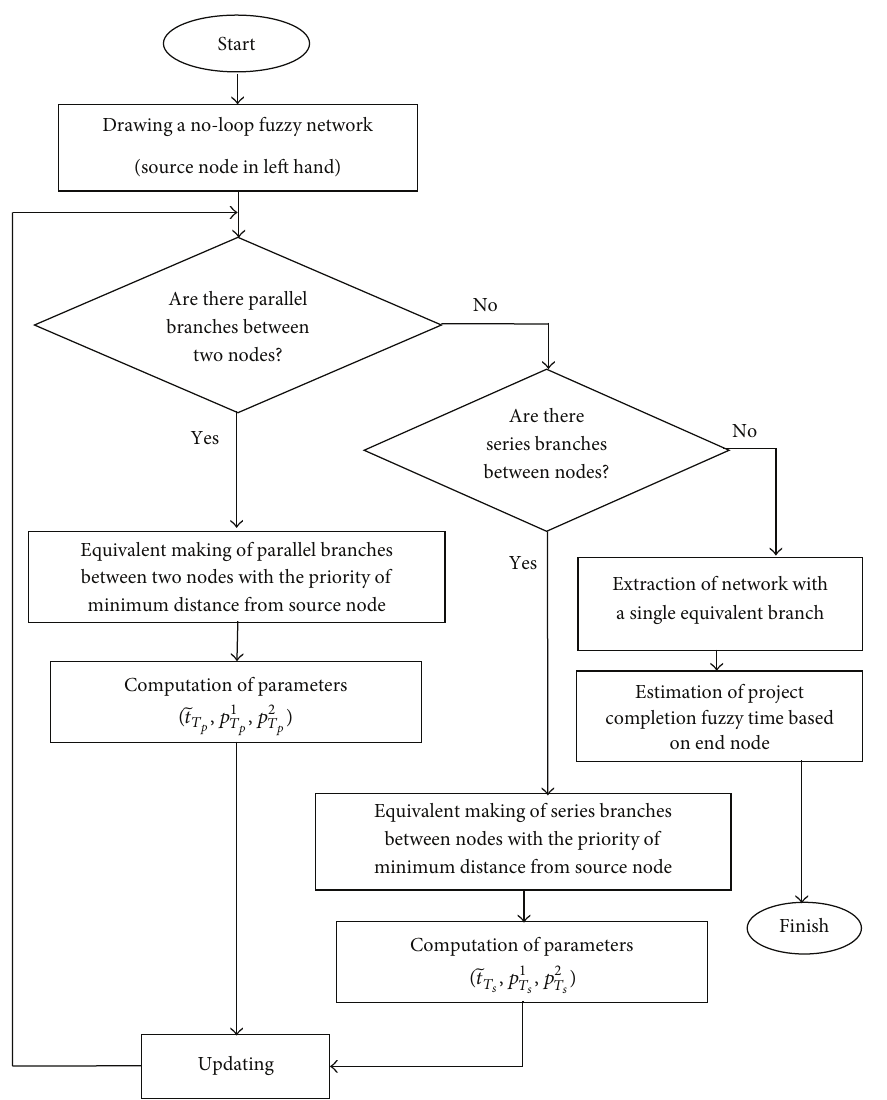
Figure 5: The proposed algorithm to resolve no-loop fuzzy networks.